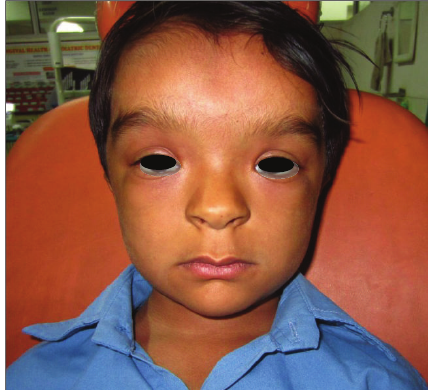
Figure 1: Facial photograph.